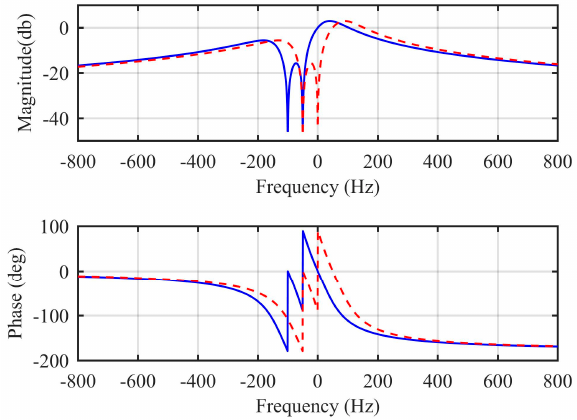
Figure 11. Bode diagram of αβ DMTOGI( s ) and dq DMTOGI( s ).